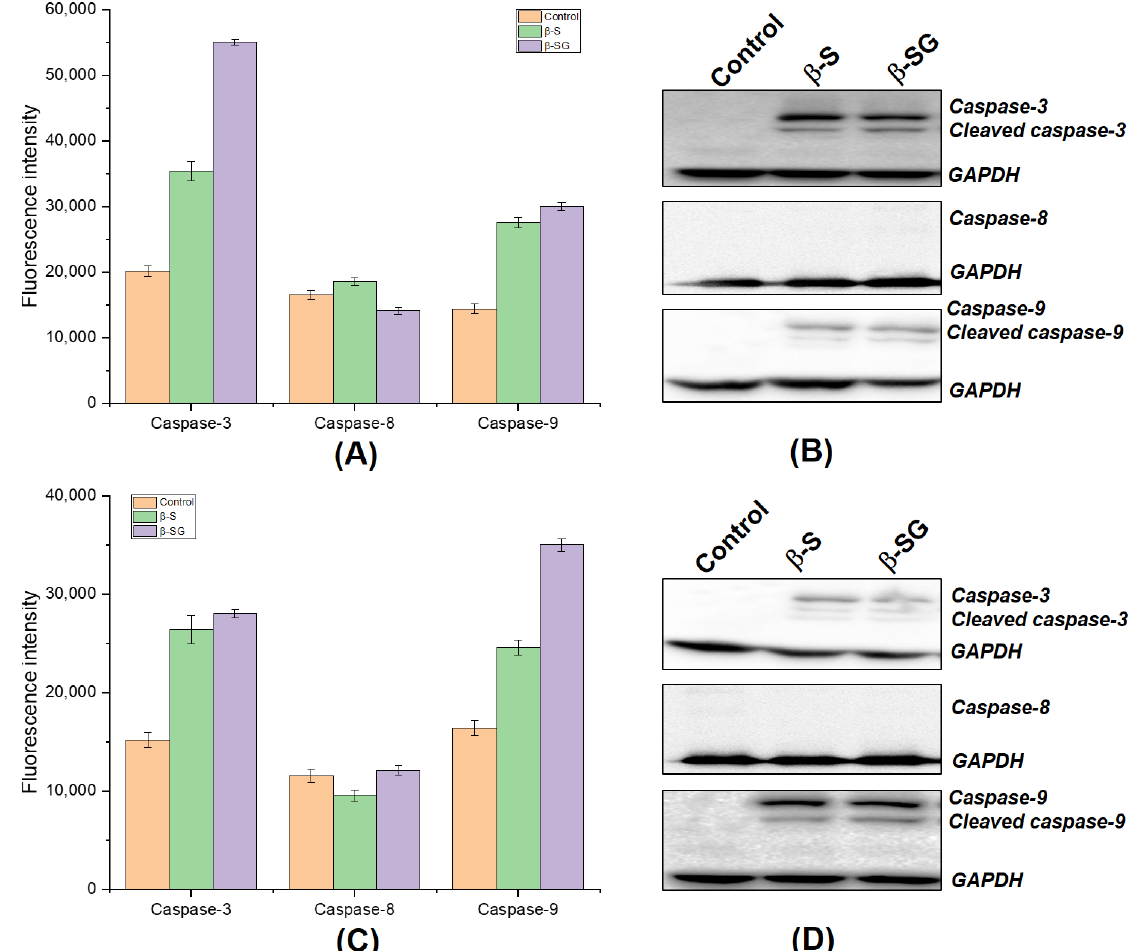
Figure 8. β-S and β-SG induced the death of liver cancer cells through caspase-dependent pathways. Measurement of the fluorescence intensity in response to caspase activities on HepG2 ( A ) and Huh7 ( B ) cells. Protein expression analysis of anti-active and its cleaved caspase-3, -8, and -9 on HepG2 ( C ) and Huh7 ( D ) cells. GAPDH was used as a loading control.